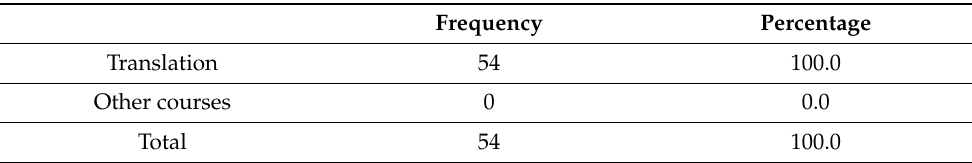
Table 4. Frequency table for courses.